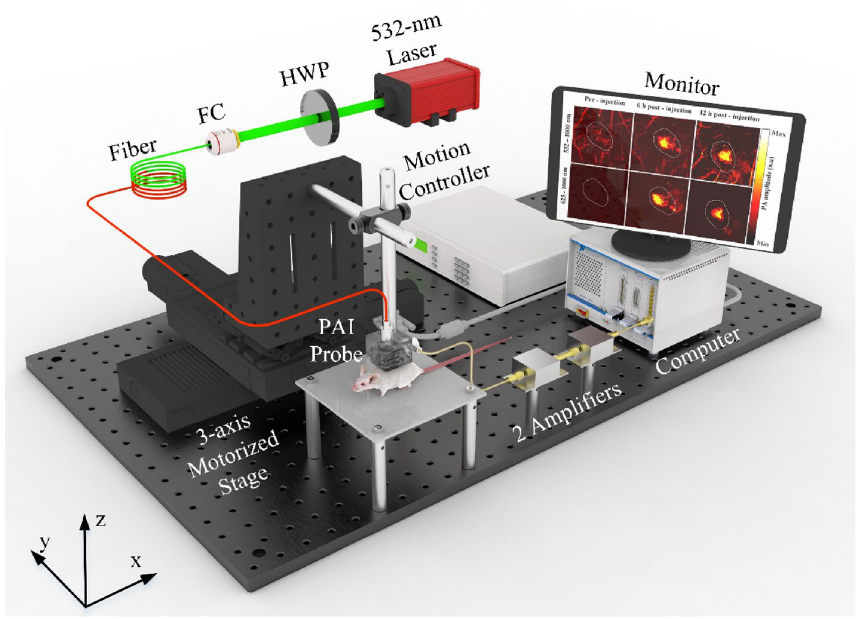
Figure 10. Schematic of the proposed photoacoustic imaging system. HWP half-wave plate, FC fiber